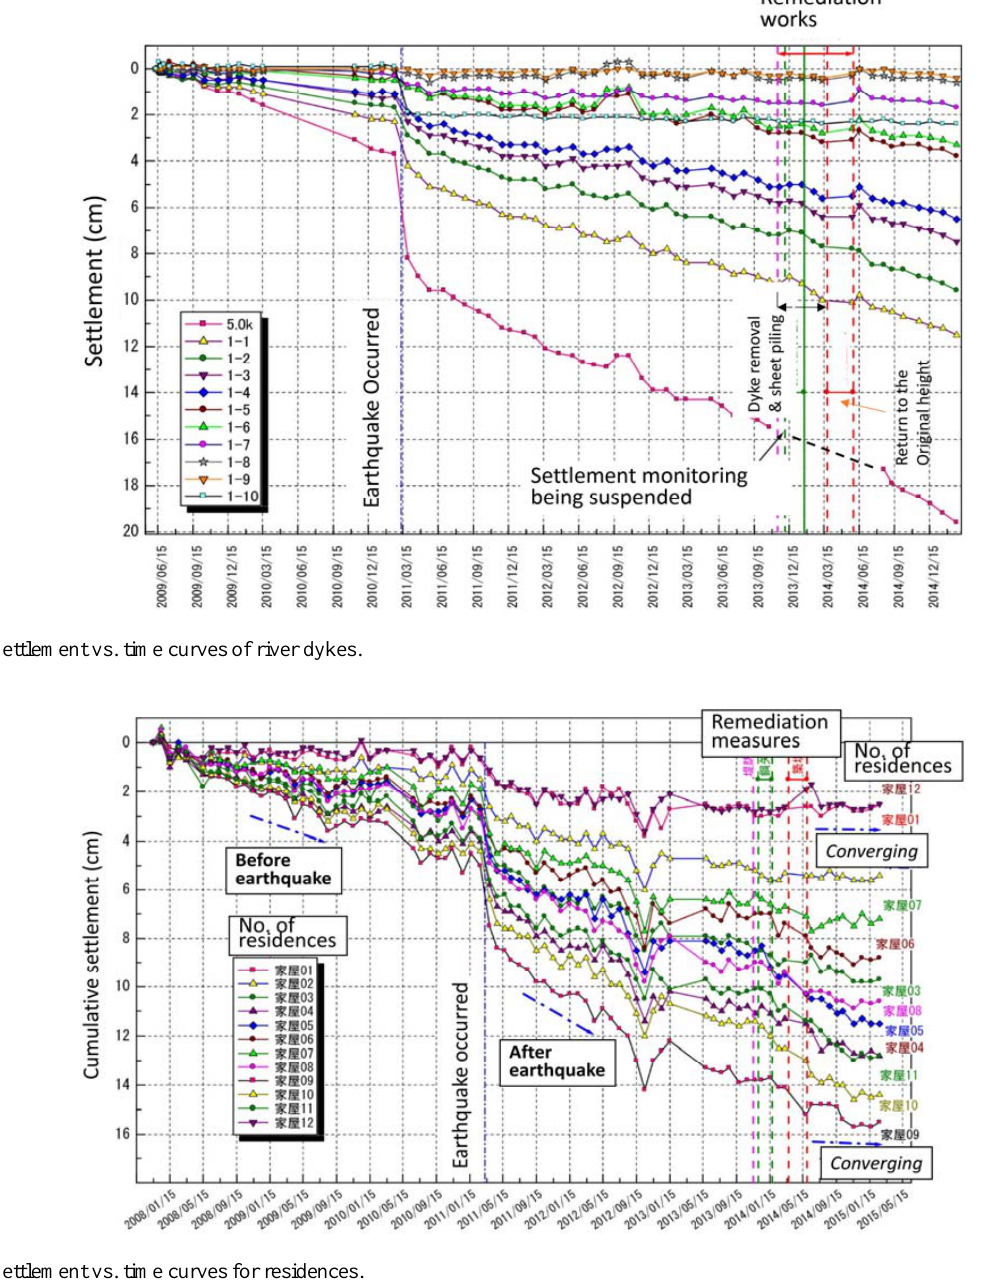
Figure 6. Settlement vs. time curves for